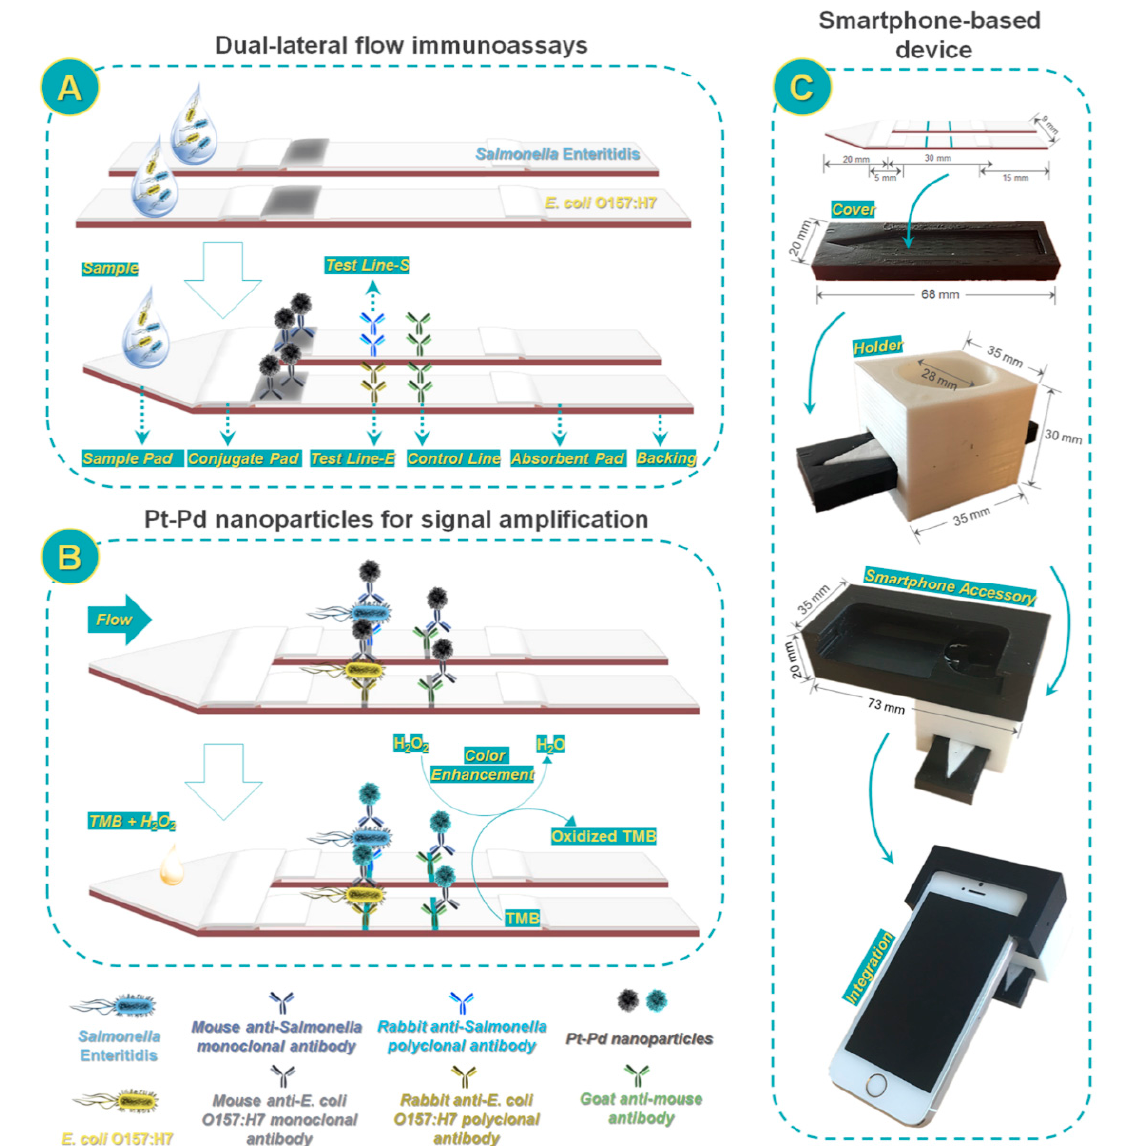
Figure 6. Scheme of smartphone-based dual lateral flow immunoassays for simultaneous detection of S. enteritidis and E. coli O157:H7 using Pd@Pt nanoparticles as signal amplification: ( A ) Dual lateral flow immunoassays; ( B ) Pd@Pt nanoparticles for signal amplification; and ( C ) smartphone-based device. Reprinted from Ref. [101], Copyright (2017), with permission from the American Chemical Society.